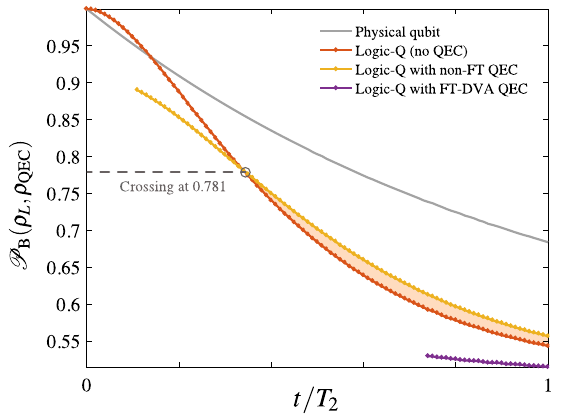
FIG. 28. Success probability P under two-species, shuttling- FIG. 29. Today ’ s hardware: Success probability P B based QEC cycles with only QEC errors: This graph shows how according to the shuttling-based, two-species protocol. The P ρ ; ρ changes with parameter λ , which is defined in the standard Alice-Igor-Bob protocol with the parameters underlying L B ð QEC Þ the simulation corresponding to the current values from main text and adjusts error rates within Igor ’ s cycle. The three Tables II – V. The red curve shown here is Bob ’ s performance plots show a non-fault-tolerant, two-species, shuttling-based in the absence of Igor, such that the occurring errors only come scheme based on two-qubit MS gates (cf. Fig. 19), and the form the environment (see Table I). For reference, the equivalent fault-tolerant DV-S scheme (cf. Fig. 21), and the fault-tolerant plot for a single physical qubit with the same environmental noise DV-A scheme (cf. Fig. 22). As described in the text, the inverted is also shown (grey curve). We see that using a logical qubit and quadratic curves, as compared to the linear behavior, are the the non-FT QEC cycle (yellow) can produce a small positive signature of a correct fault-tolerant circuit. The simulation effect; the shaded area indicates this beneficial region. However, parameters correspond to the future improved values from the fully FT protocol (purple line), when it is possible (see main Tables II – V. The noise applied for the imperfect two-ion MS text), is always gate operations follows the standard depolarizing model.